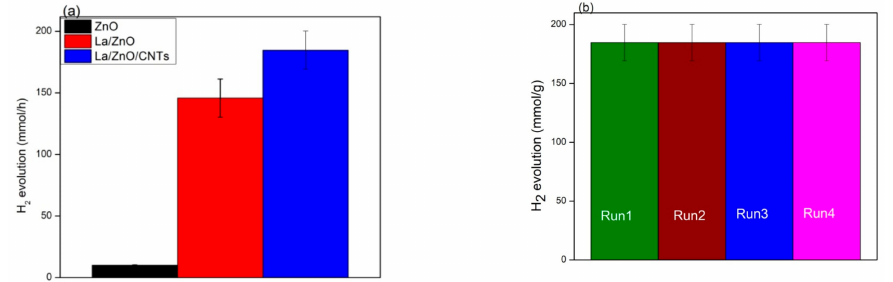
Figure 9. ( a ) H 2 evolution rates over pristine ZnO, La/ZnO, and La/ZnO/CNTs after 4 h of visible light illumination. Error bars indicate the standard deviation measured by three independent experiments; ( b ) Stability of La/ZnO/CNTs after successive five cycles. The error bar indicates the standard deviation measured by three independent